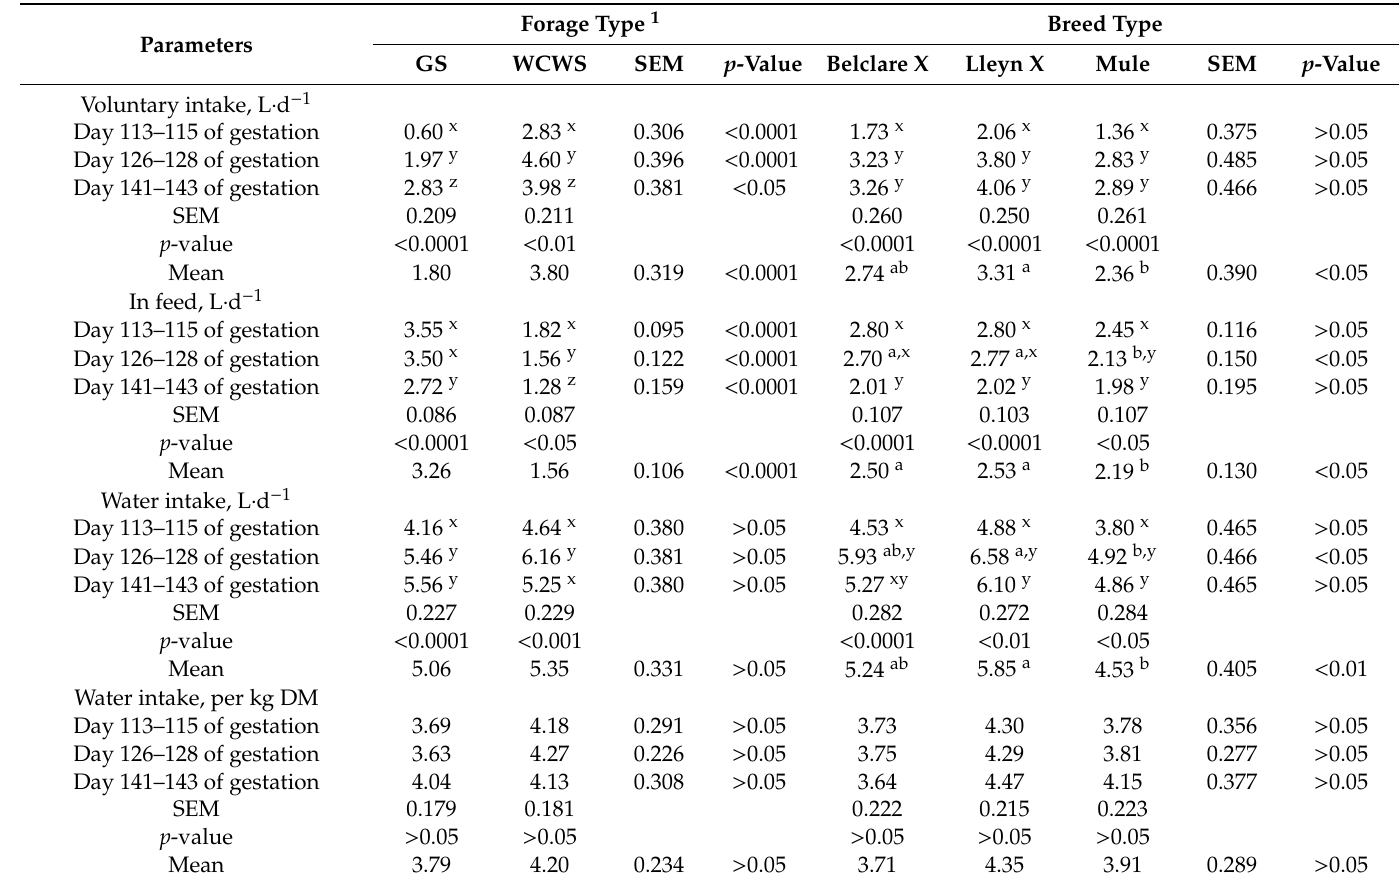
Table 3. The e ff ect of forage type and breed type on ewe water intake during late gestation (least square means ±